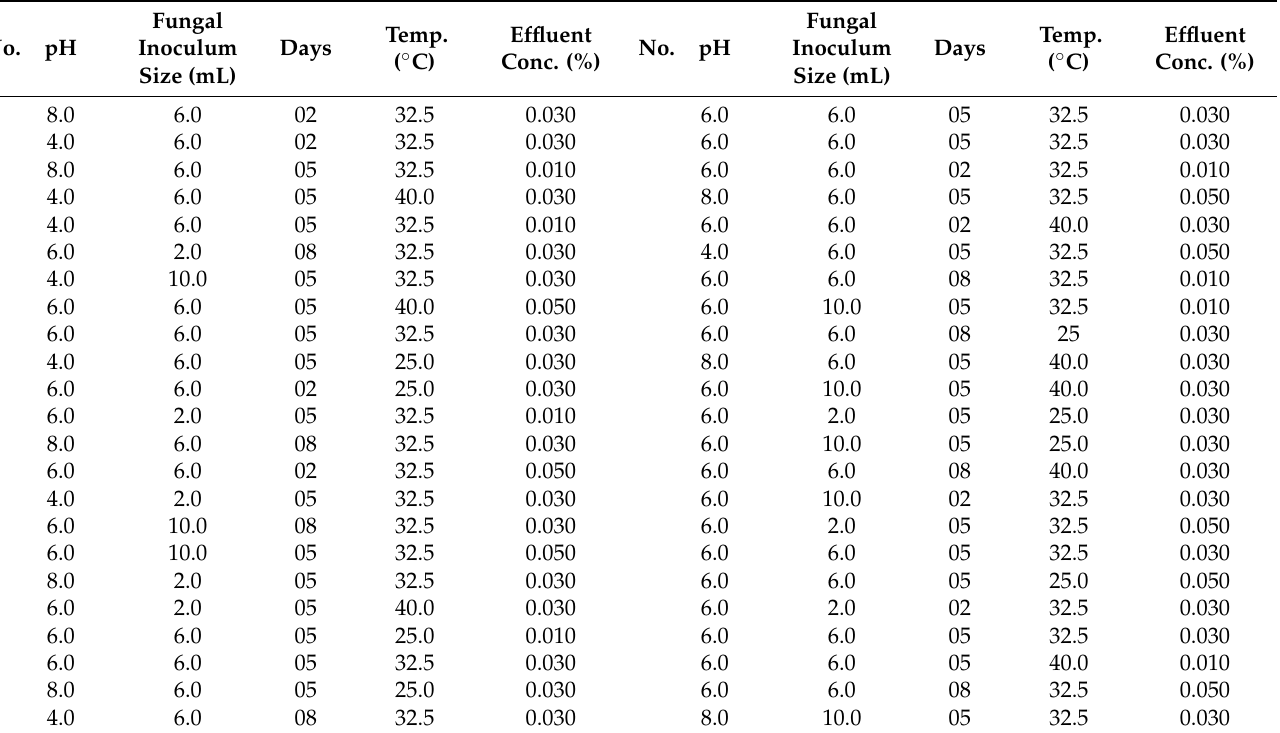
Table 1. Experimental design for the optimization of physical parameters during the biodegradation of effluents (Conc. are in % age by Volume).